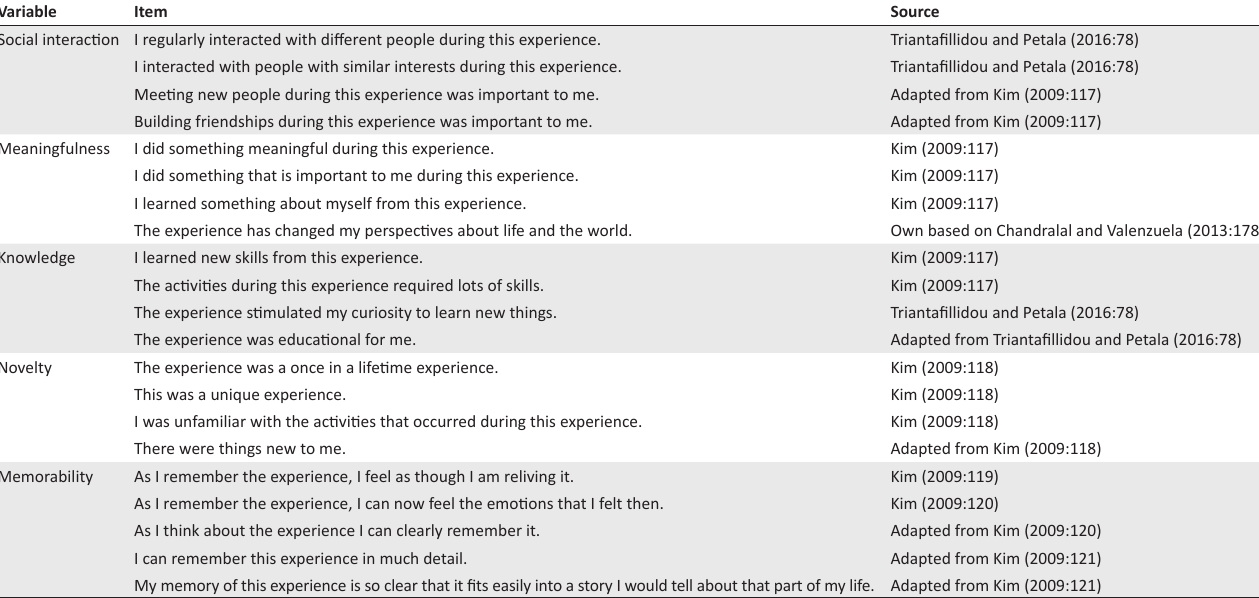
TABLE 1-A1: Sources of scale items.